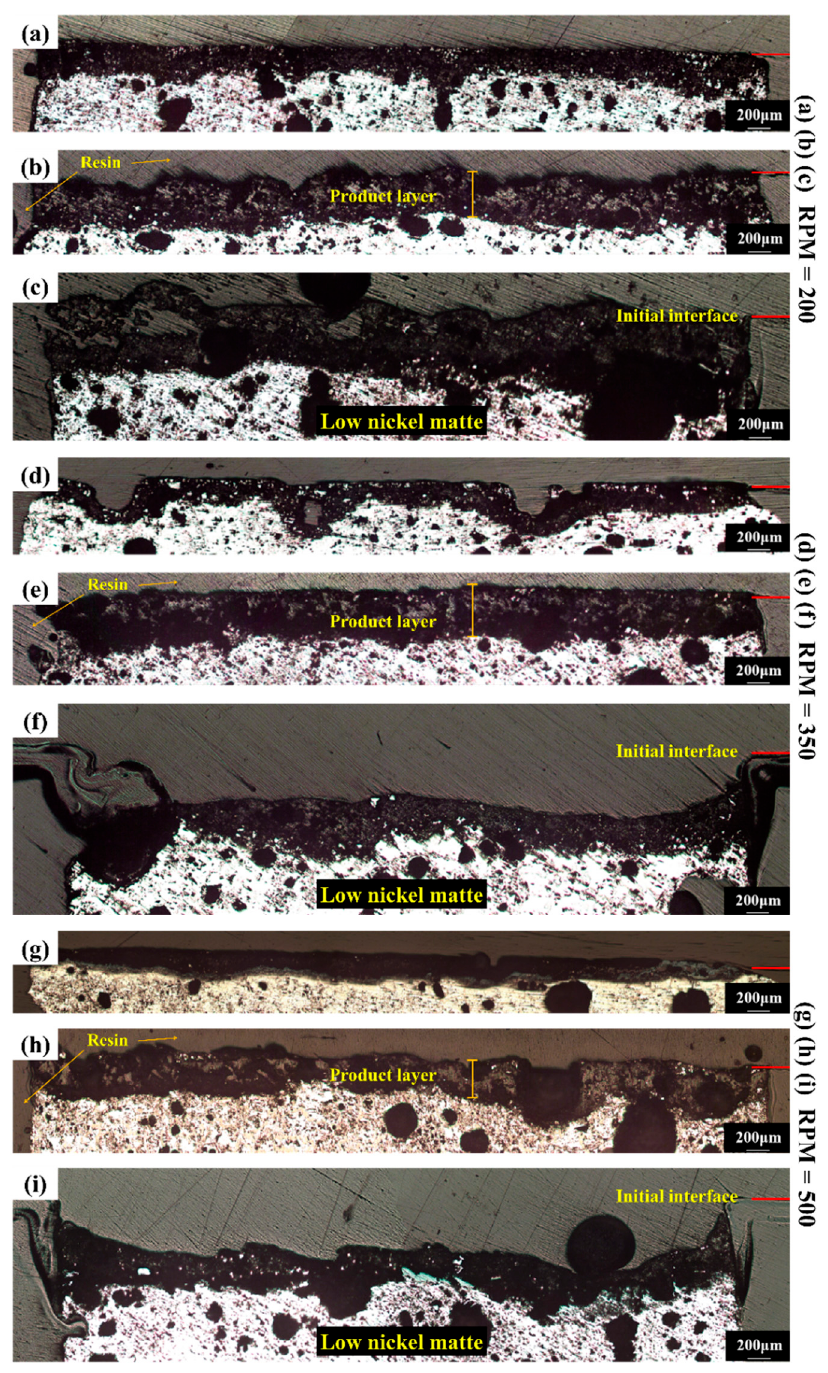
Figure 8. ( a – c ) OM images of the low-nickel matte with the addition of quartz sand at 200 RPM after 1, 2, and 3 h leaching, respectively; ( d – f ) OM images of the low-nickel matte with the addition of quartz sand at 350 RPM after 1, 2, and 3 h leaching, respectively; ( g – i ) OM images of the low-nickel matte with the addition of quartz sand at 500 RPM after 1, 2, and 3 h leaching, respectively.